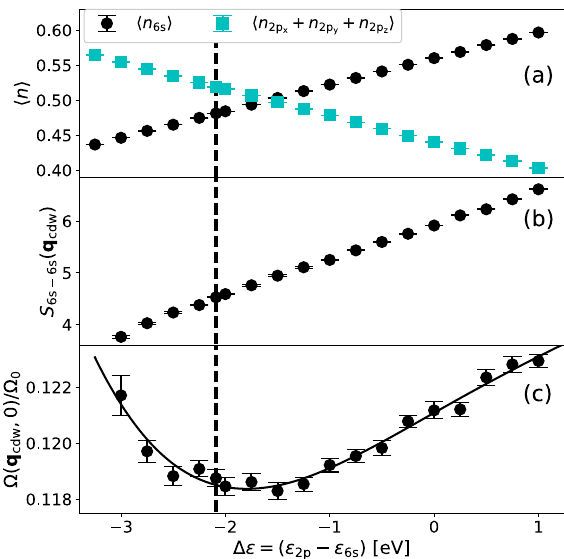
Figure 5b examines how the distribution of holes affects the charge correlations. Increasing Δ ϵ not only increases 〈 n 6 s 〉 but S 6s